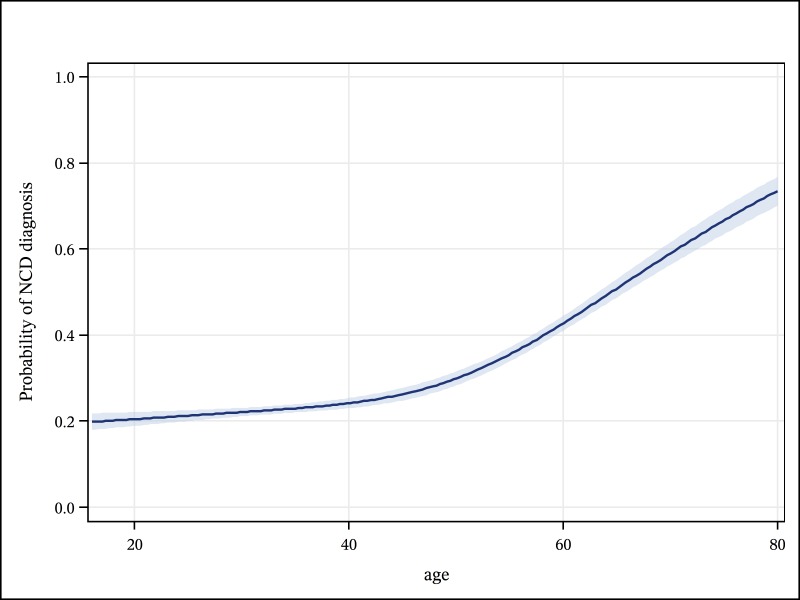
Predicted probablility (with 95% confidence limits) of a non-communicable disease diagnosis, by age, in adult inpatients, Blantyre, Malawi- 2013 to 2014.